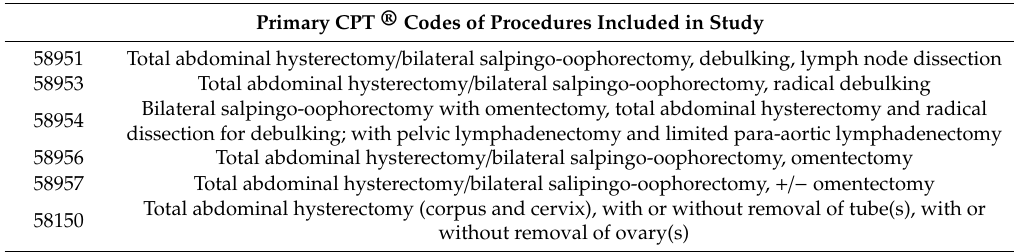
Table A1. Primary current procedure terminology codes included in the study.